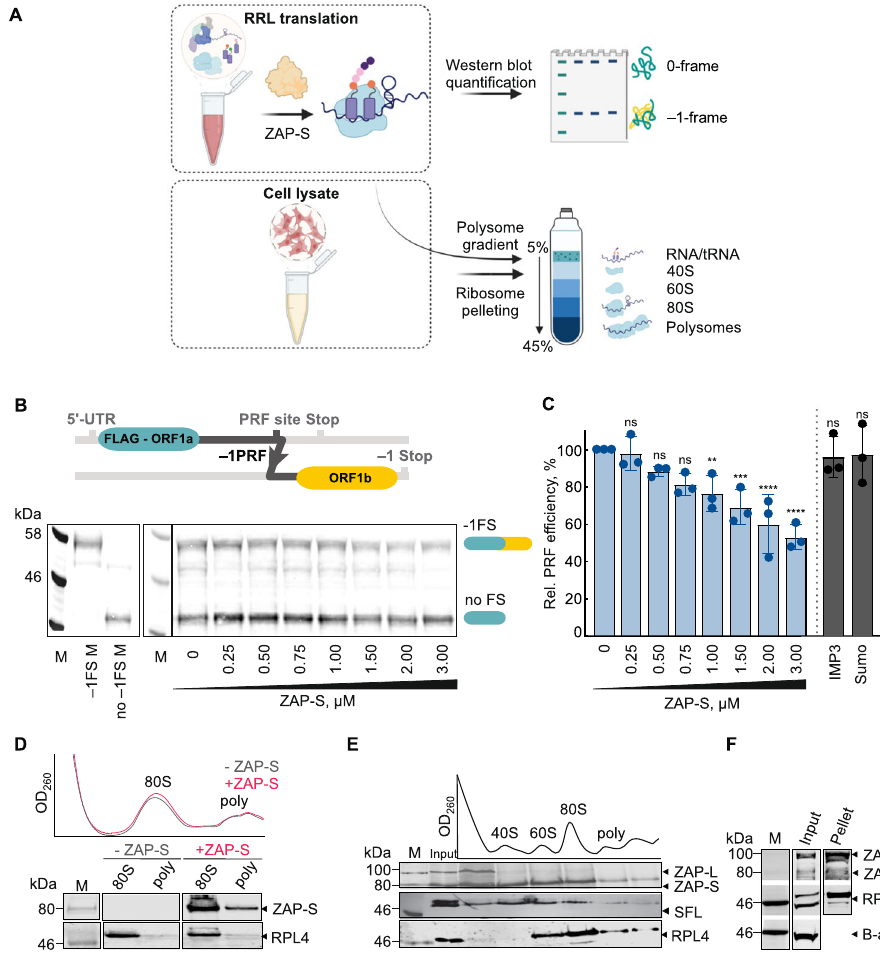
Fig. 3 Effect of zinc- fi nger antiviral protein (ZAP) on 1a/1b – 1 frameshifting in vitro. A The strategy of the in vitro translation assay using rabbit reticulocyte lysate (RRL) and the experimental work fl ow to study ribosome association of ZAP-S. B Schematics of the N-terminal FLAG-tagged frameshifting reporter consisting of the nucleotides 12686-14190 (~1.5 kb) of the SARS-CoV-2 genome. RNAs were translated in RRL in the presence of increasing concentrations of ZAP-S ranging from 0 to 3 µ M. FLAG-tagged peptides generated by ribosomes that do not frameshift (no – 1PRF) or that enter the − 1 reading frame ( − 1PRF) were identi fi ed via western blotting using anti-DDDDK antibody. FE was calculated as previously described 11 , by the formula: Intensity ( – 1-frame)/ (Intensity ( – 1-frame) + Intensity (0-frame)). Size markers - M (Marker), – 1PRF M ( – 1-frame marker), and no – 1PRF M (0-frame marker). n = 3 independent experiments. C Changes in FE observed in the presence of ZAP-S from ( B ) (normalized to 0 µ M ZAP as shown in B ). P values were calculated using an ordinary unpaired one-sided ANOVA comparing every concentration to the no ZAP control. * P < 0.05, ** P < 0.01, *** P < 0.001, **** P < 0.0001. Exact P values: 0.25 µ M – 0.82, 0.50 µ M – 0.26, 0.75 µ M – 0.06, 1.00 µ M – 0.009, 1.50 µ M – 0.0002, 2.00 µ M – <0.0001, 3.00 µ M – < 0.0001. See also Supplementary Fig. 2 and Supplementary Table 3. D Polysome pro fi ling analysis of ZAP-S in RRL. RRL translating the FLAG-tagged SARS- CoV-2 frameshifting reporter was subjected to 5 – 45% sucrose gradient ultracentrifugation, and subsequently fractionated. Levels of RPL4, as well as ZAP in each fraction, were analyzed by western blotting using anti-RPL4 and anti-ZC3HAV1 (ZAP) antibodies. n = 2 independent experiments. E Ribosome pelleting of untreated Calu-3 cells. Naïve Calu-3 cells were lysed and loaded onto sucrose cushions. Levels of RPL4, ZAP, and β -actin in the pellets were analyzed by western blotting using anti-RPL4, anti-ZC3HAV1 (ZAP) and anti- β -actin antibodies. n = 3 independent experiments. F Polysome pro fi ling analysis of ZAP-S in cells. HEK293 cells transiently expressing ZAP-S were lysed, subjected to 5 – 45% sucrose gradient ultracentrifugation, and subsequently fractionated. Levels of ribosomal proteins, ZAP as well as SHFL in each fraction, were analyzed by western blotting using anti-RPL4, anti- ZC3HAV1 (ZAP) and anti-RYDEN (SHFL) antibodies. n = 3 independent